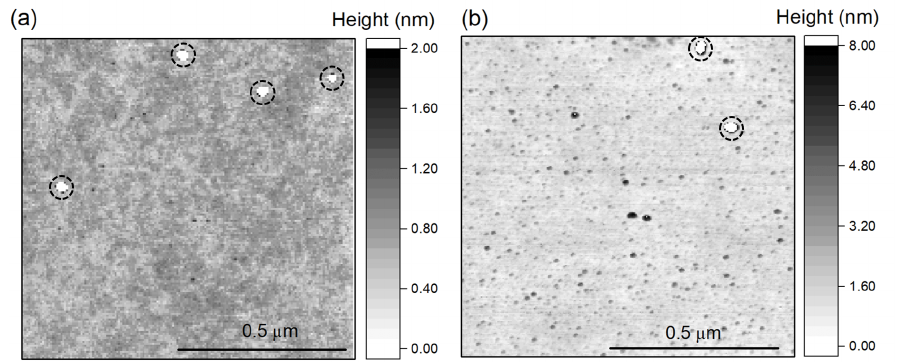
Figure 4. ( a ) Surface roughness of a membrane etched with the SF 6 -based plasma process to thickness of 2.5 µ m. Image recorded using a FastScan-ScanAsyst atomic force microscopy (AFM, Bruker, Billerica, MA, USA) in tapping mode. The four encircled bumps exceed the chosen scale bar and are 9.3nm high; ( b ) Membrane etched using the Cl 2 -based process to a thickness of 9 µ m. Image recorded using a Dimension 3100 AFM in tapping mode. The two encircled bumps marked exceed the chosen scale bar and are 18nm